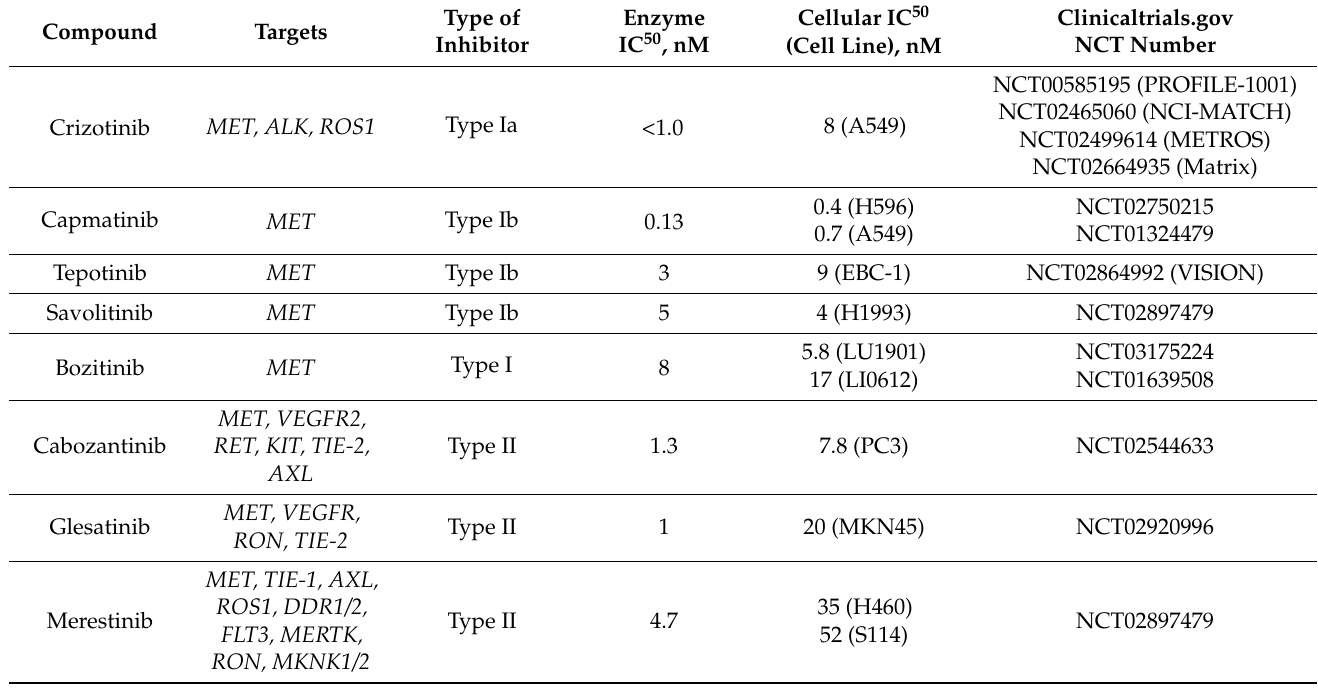
Table 1. TKIs Targeting MET ex14 skipping